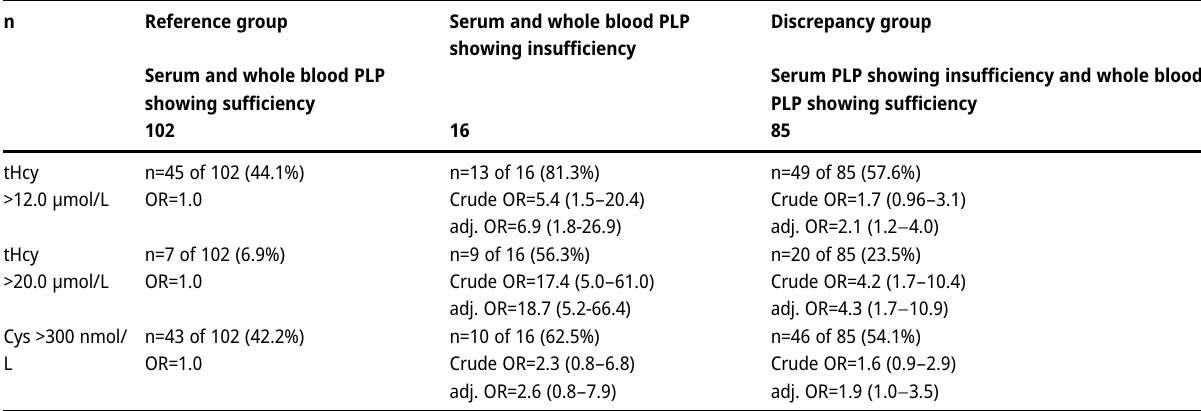
Table  : The frequency and probability of elevated total homocysteine and cystathionine concentrations in samples with concordant and discordant concentrations of PLP in serum and whole